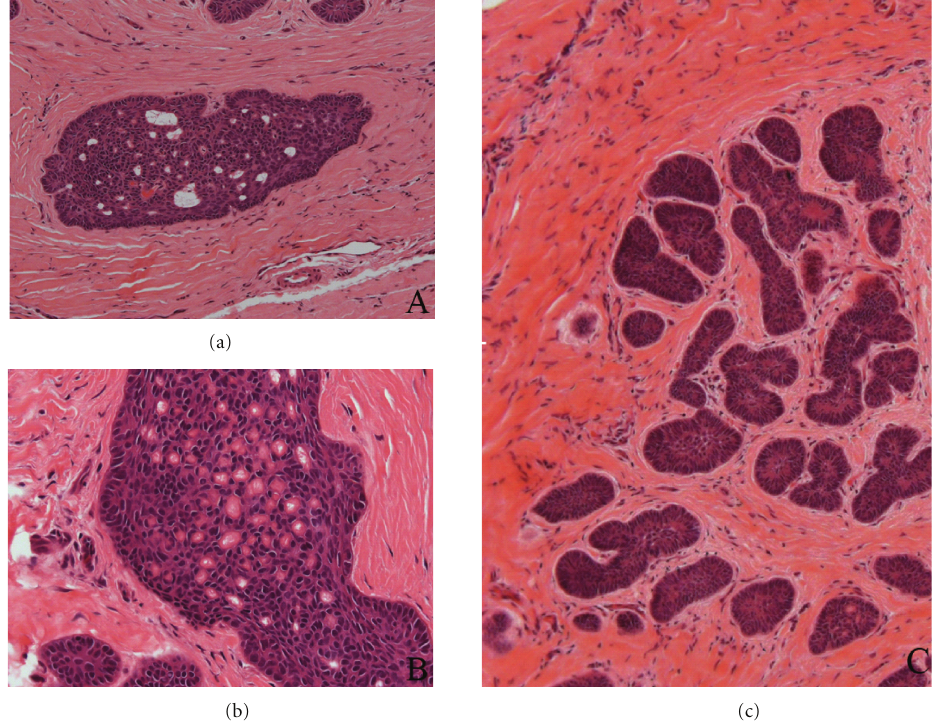
Figure 3: (a) Cystic formations in an ameloblastomatous nest (H&E, 20x); (b) squamous metaplasia seen in an ameloblastomatous nest (H&E, 20x). (c)Stroma surrounding the odontogenic epithelial islands with a more fibrous arrangement than that outer connective tissue (H&E,